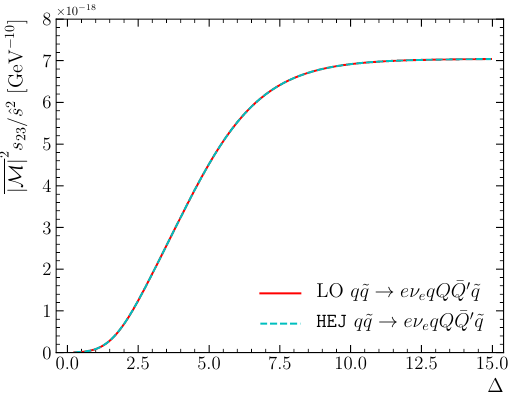
Figure 11. Plot illustrating the scaling of the HEJ approximation to the matrix element (cyan, ¯ dashed) for q ˜ q → eν Q 0 ˜ q . The parameter ∆ represents the rapidity separation of the coloured e qQ particles as described in the text. Also shown is the leading order result (red, solid). We see that the expected scaling relation eq. (3.36) is obeyed, and that the HEJ approximation gives a good description of the full LO matrix element across the whole range of ∆